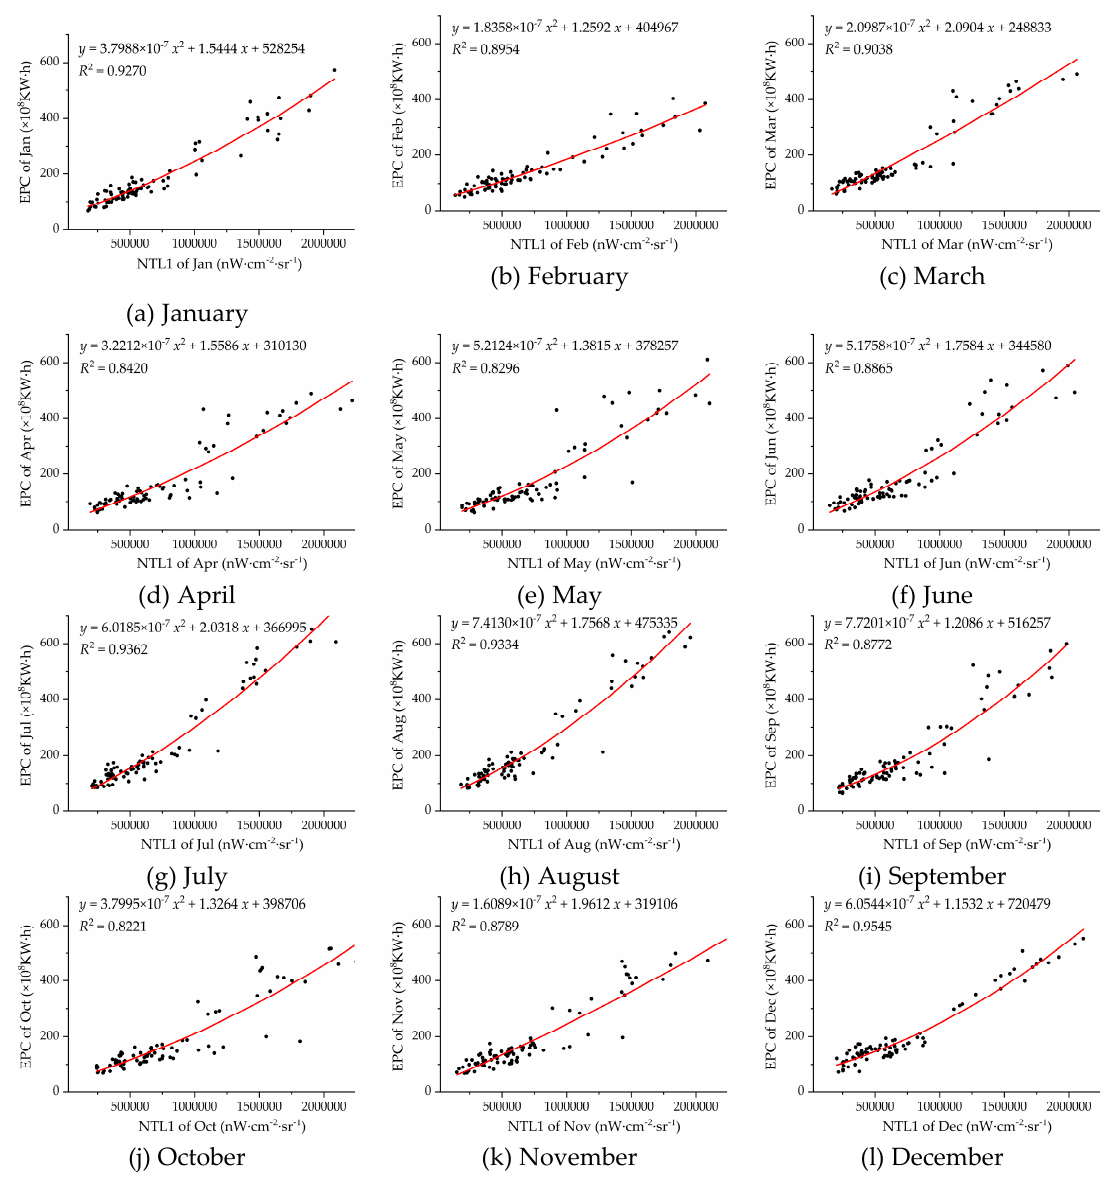
Figure 5. Polynomial regression between NTL 1 and EPC for each month. Panel ( a )–( l ) represents the regression of January to December, respectively. The x -axis refers to NTL 1 in units of nW/(cm 2 ·sr). The y -axis refers to EPC in units of 10 8 KW·h.